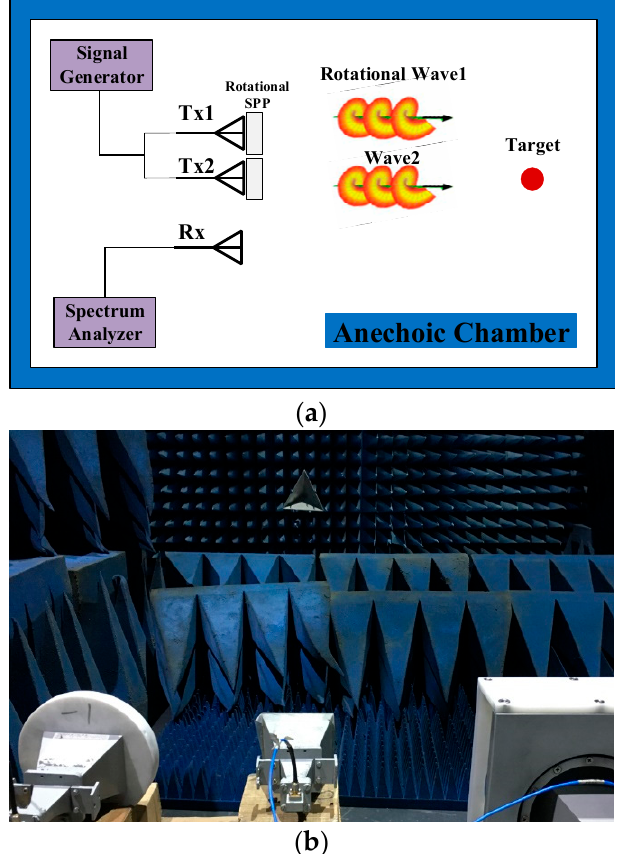
Figure 8. ( a ) Schematic configuration of the MISO mode; ( b ) experimental scenario of the MISO mode.